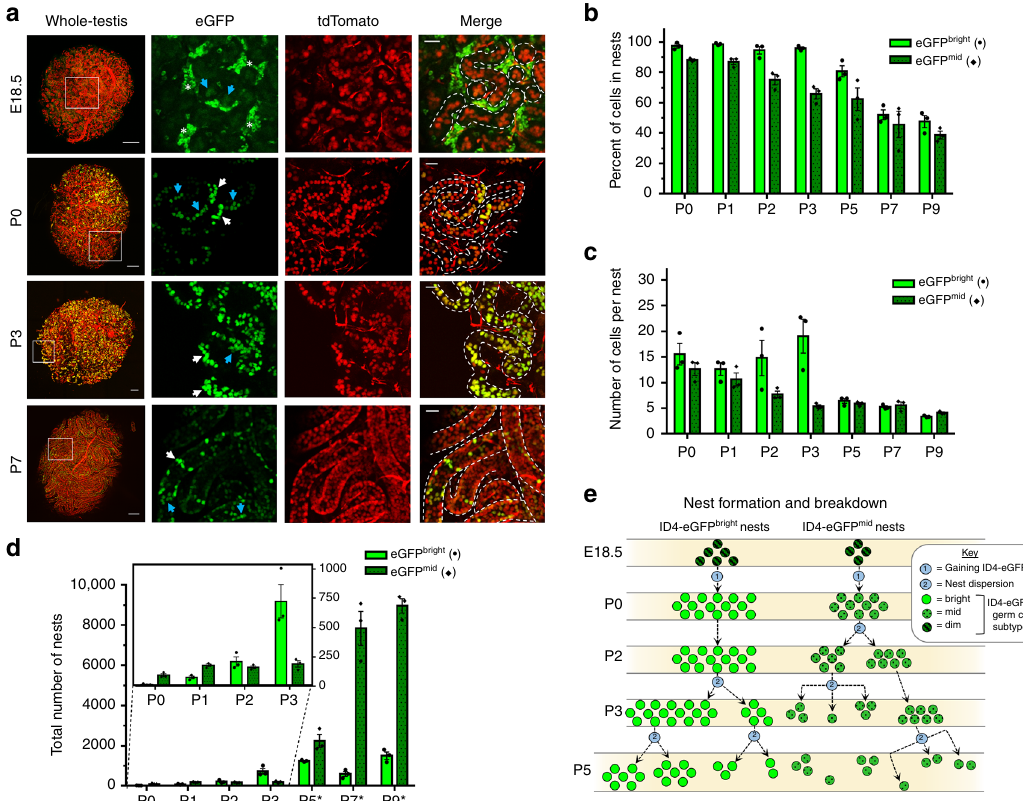
Fig. 3 ID4-eGFP germ cells form nests during fetal and neonatal development. a Whole testes were imaged by 3D confocal microscopy. Select confocal slices from complete testis Z-stacks (Whole-Testis panels, white square) illustrate examples of ID4-eGFP Bright (eGFP panels, white arrows) and ID4- eGFP Mid (eGFP panels, blue arrows) nests among all tdTomato + germ cells. Seminiferous tubule borders are outlined (white dotted lines) and embryonic interstitial Leydig cell auto fl uorescence is indicated (E18.5, eGFP, white asterisks); eGFP, tdTomato, and Merged panels share equal scales (scale bar, 50 µ M) different from Whole-Testis panels (scale bar, 200 µ M). b – d Percent of cells in nests ( b ), average nest size ( c ), and total number of nests ( d ) were quanti fi ed from 3D confocal images for ID4-eGFP Bright and ID4-eGFP Mid populations. Total number of nests for P5, P7, and P9 were estimated as outlined in the section “ Methods ” ( d , asterisks). Data are presented as means with error bars representing SEM for n = 3 biologically independent animals at each age point. Source data are provided as a Source Data fi le. e Schematic portraying eGFP + germ cell nest dynamics. Numbering key indicates